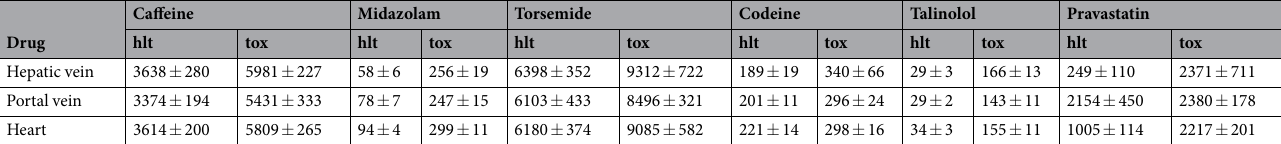
Table 4. Mean AUCs ( ± SD) [ µ mol * min/l] of the experimental PK data for the healthy (hlt) and the damaged (tox) case at the three sampling sites.